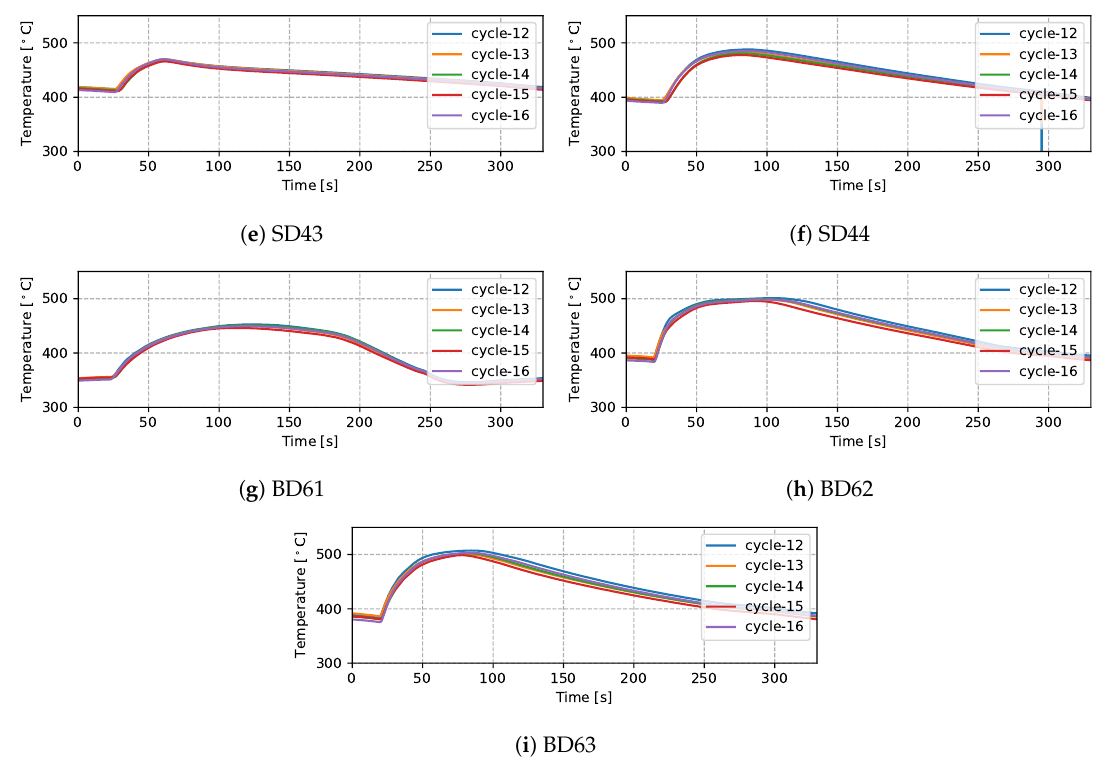
Figure 6. Measured temperatures from different locations (five cycles)—non-production process condition.